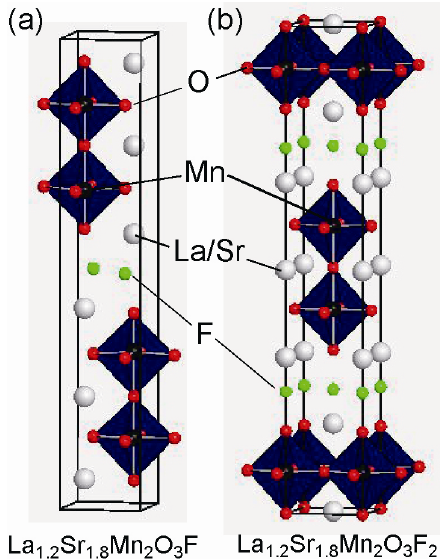
Figure 7. Crystal structure of Sr